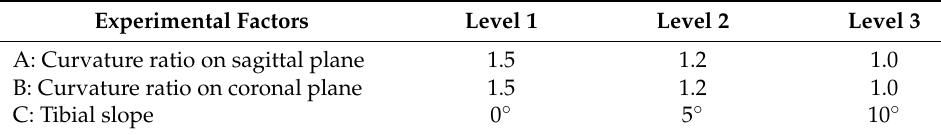
Table 1. Knee implant experimental factors and design levels. Experimental